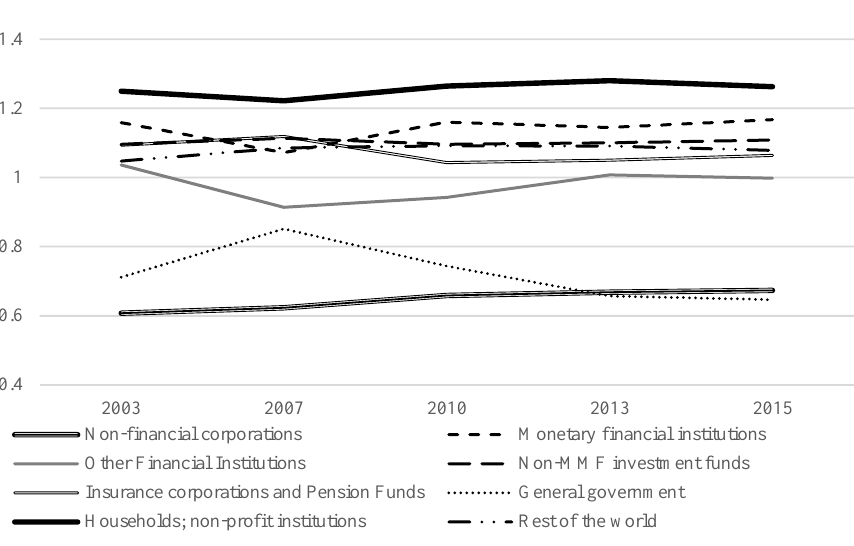
Figure 6. Power-of-dispersion indices for the Polish institutional